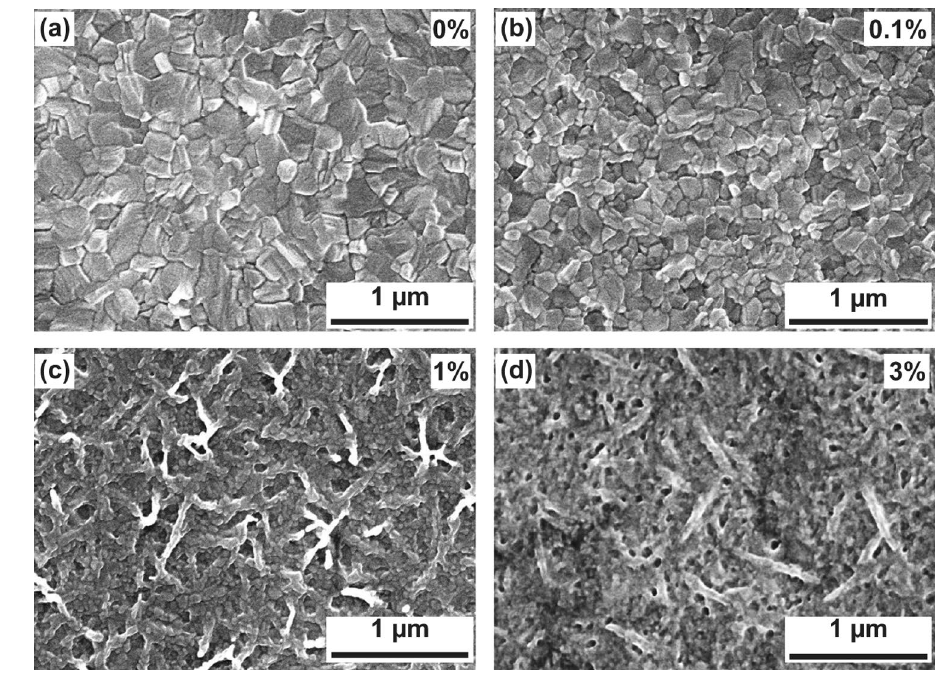
Fig. 2 Top view SEM images of the MAPbI 3 films with different PEA concentrations with a 0 wt%, b 0.1 wt%, c 1 wt%, and d 3